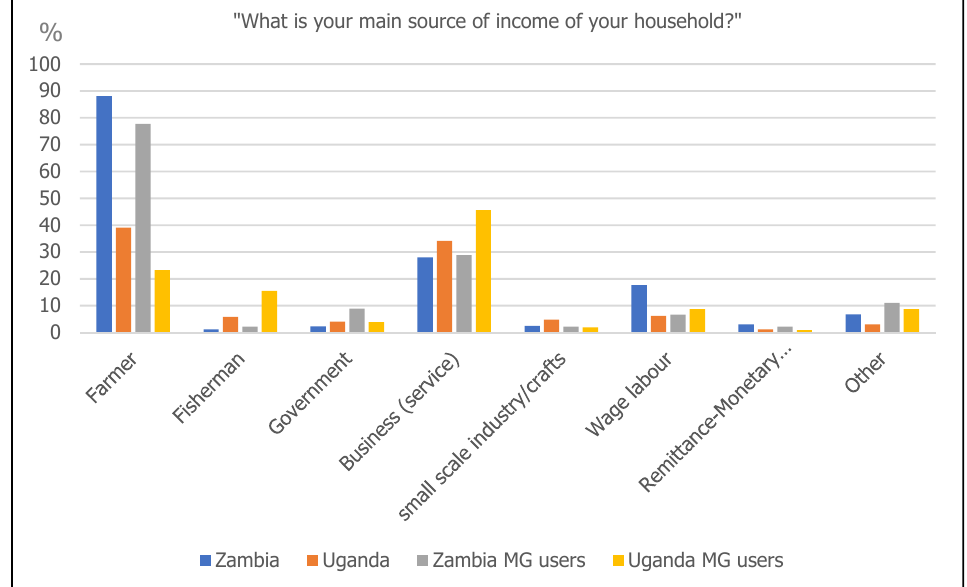
Figure 2. Socio-economic characteristics of rural communities in Uganda and Zambia ( N = 1016; Responses in %; Multiple responses possible).